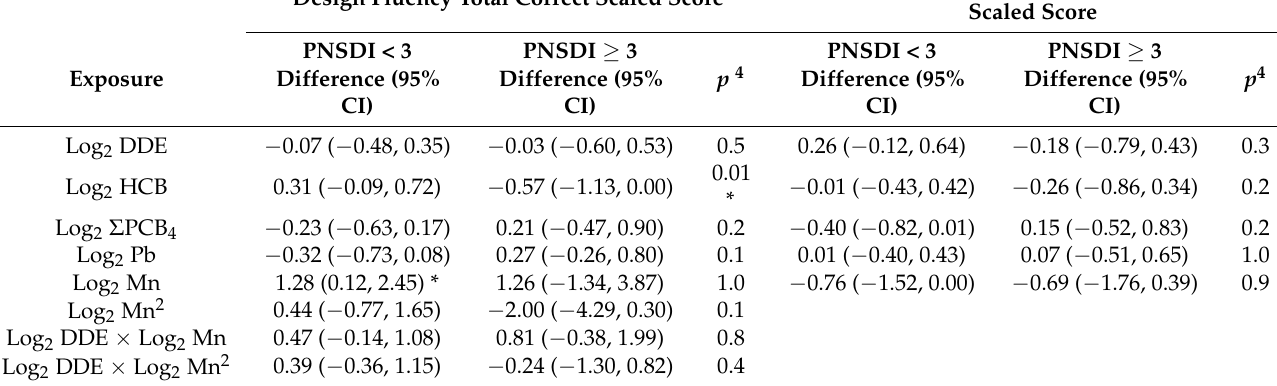
Table 4. Prenatal social disadvantage index (PNSDI) 1 -stratified results of multivariable linear regression analyses (difference in scaled scores associated with a twofold increase in exposure and 95% CI) 2 assessing the relation of prenatal exposure to a five-chemical mixture with Delis–Kaplan Executive Function System inhibition scaled scores among adolescents in the main analysis group 3